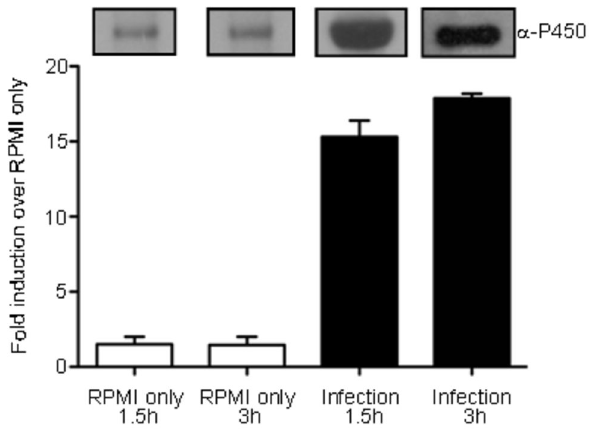
Figure 3. qRT-PCR analysis of Cj1411c gene expression during infection. Cj1411c expression analysis in C. jejuni 81-176 following infection of HCT-8 cells. The gene expression level for 1.5h in RPMI was set to 1 as the basal level. All other levels are expressed as fold change over the basal gene expression. Error bars represent ±S.D. of 3 independent experiments. The corresponding protein expression levels assessed by Western blot with the anti-P450 antibody are